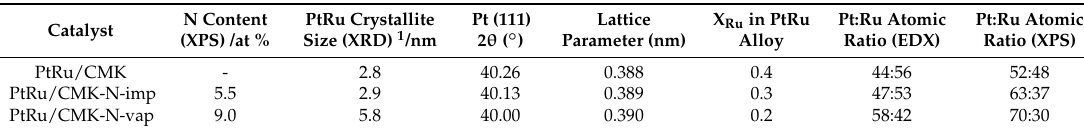
Table 3. Physico-chemical features of PtRu/C